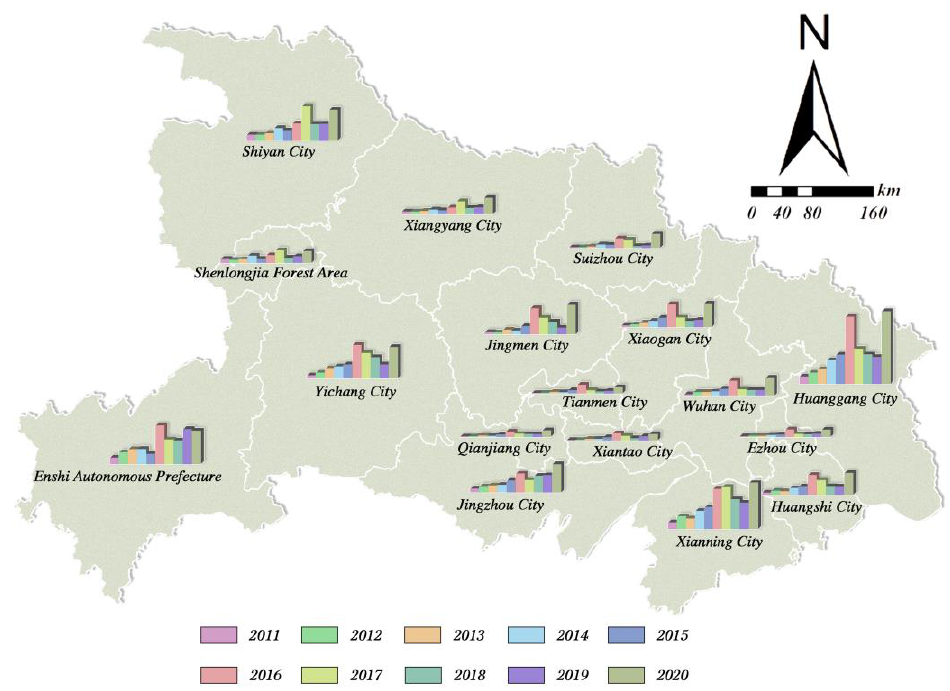
Figure 4. Total liabilities of water resources in Hubei Province from 2011 to 2020. According to the total assets and liabilities of water resources obtained by the equal weighting method, the net assets of water resources of 17 cities in Hubei Province are calculated using Equation (12). The results are presented in Table 7. Table 7. Net assets of water resources in Hubei Province from 2011 to 2020 (in billions of USD).